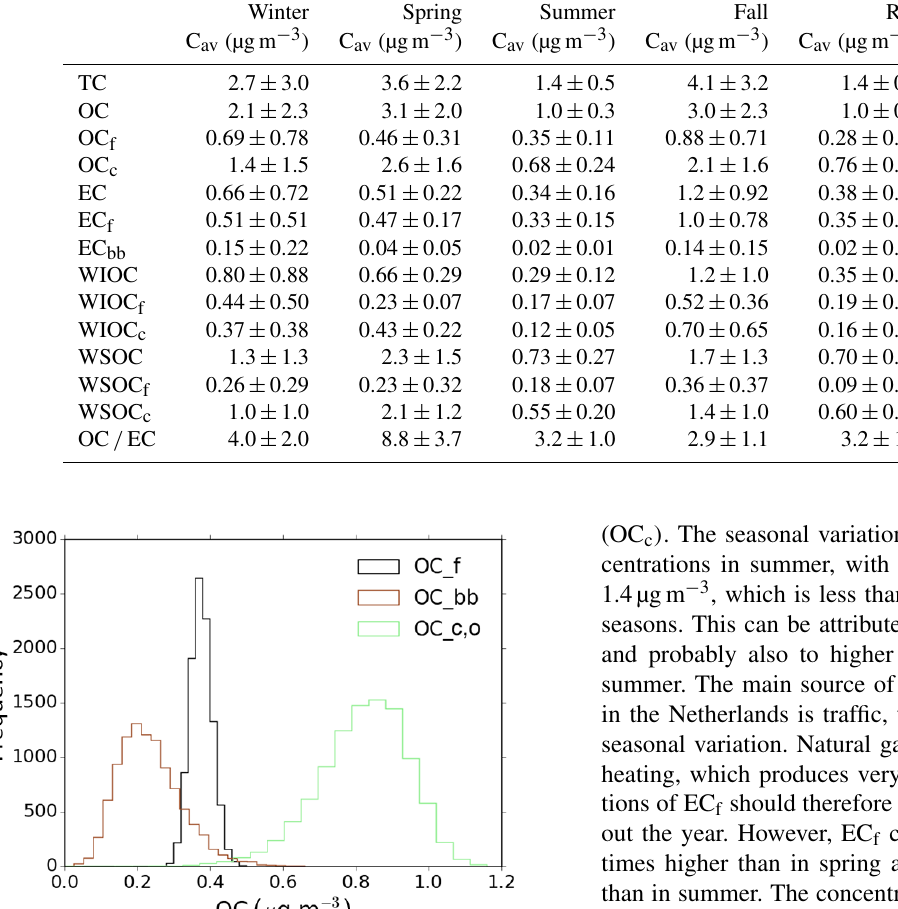
Table 3. Average concentrations of OC, EC, WIOC, and WSOC and the respective contribution of contemporary (c) and of fossil-dominated (f) sources for different seasons and for regional (reg) and continental (cont) air mass conditions. The subscript c stands for all contemporary carbon, i.e., the sum of biomass burning and other contemporary carbon (e.g., OC c = OC bb + OC c , o ) . Winter Spring